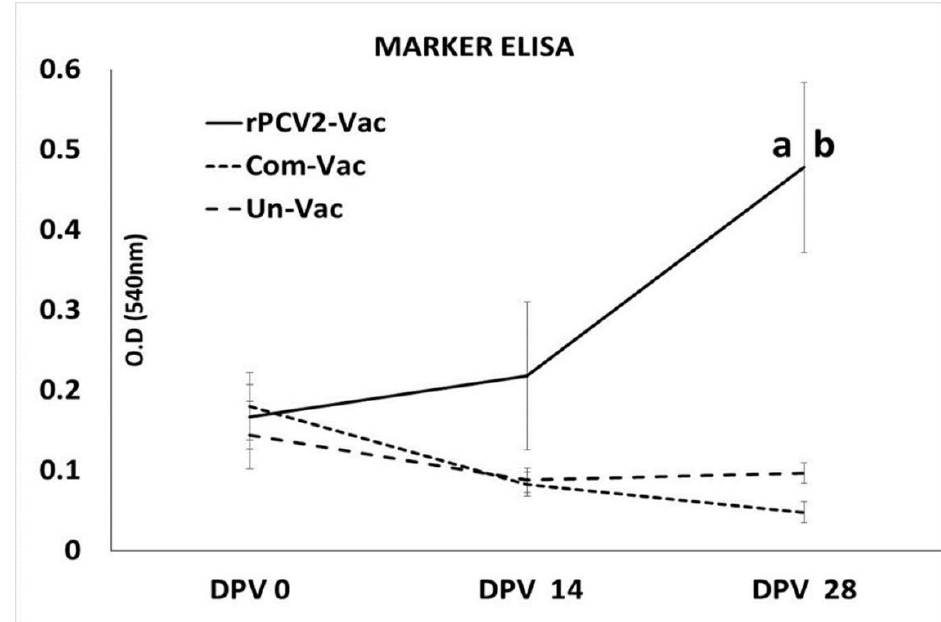
Figure 6. Antibody responses to the marker: Mean optical density values of sera collected on days 0, 14 and 28 post vaccination (DPV) ( N = 9), as measured by an ELISA specific to an antigenic peptide selected from the Neospora caninum SRS2 protein. X axis: time points of serum collection, Y axis: mean optical density (O.D) value, solid line: rPCV2-Vac, dotted line: commercial vaccine, dashed line: unvaccinated group. Error bars indicate the standard deviation, a: significantly different from the unvaccinated control, b: significantly different from the commercial vaccine group; p ≤ 0.05; Students t test.